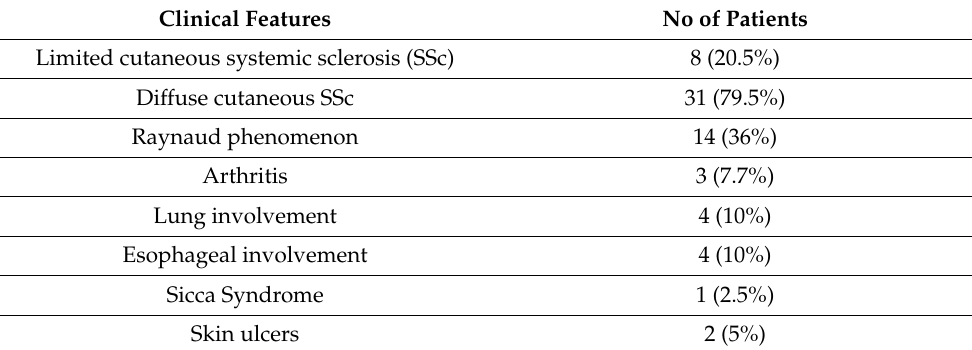
Table 1. Clinical characteristics of the patients included in the